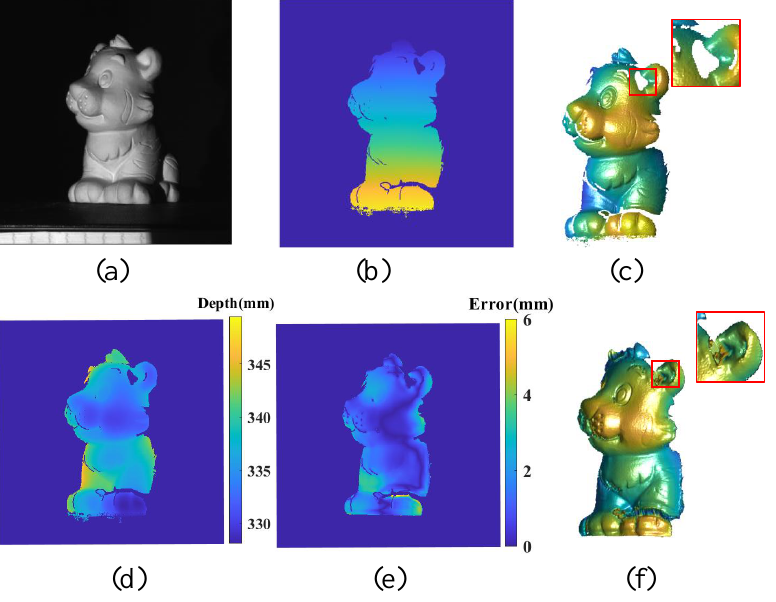
Figure 5. Effectiveness evaluation of the proposed model for scanning a single object in the real-world FPP system. ( a ) Texture image; ( b ) Unwrapped phase map; ( c ) 3D reconstructed geometry from FPP; ( d ) The depth map from FPP; ( e ) The error map for the non-shadow covered region with RMSE 1.5031 mm; ( f ) 3D reconstructed geometry from the predicted depth map.